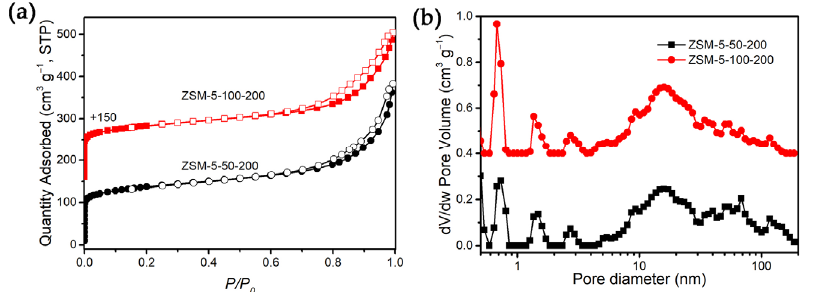
Figure 10. N 2 physisorption isotherms ( a ) and pore-size distribution obtained by the NLDFT